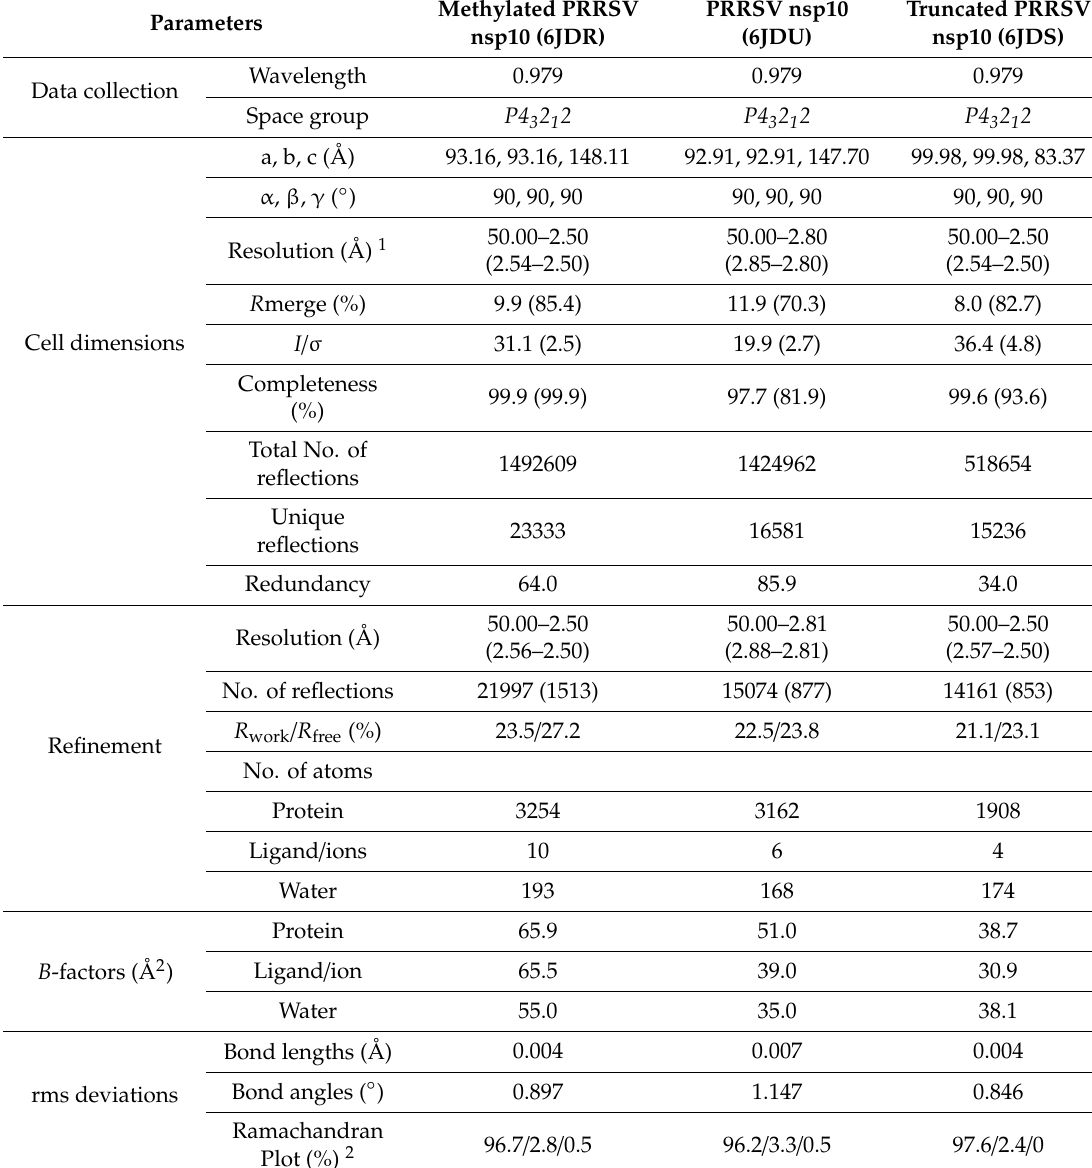
Table 1. Data collection and refinement statistics of PRRSV